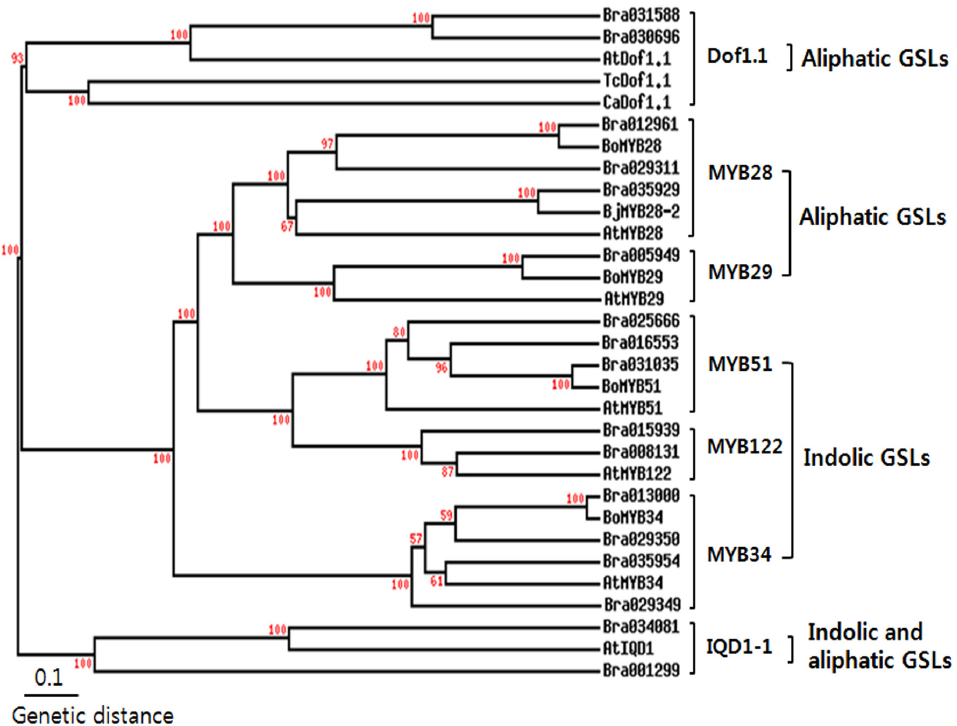
Figure 2. Phylogenetic tree of MYB transcription factors of B. rapa with other plants. The phylogenetic tree was generated by applying the cluster algorithm using TreeTop Phylogenetic tree. Bootstrap values were resample 100 times. GenBank Accession